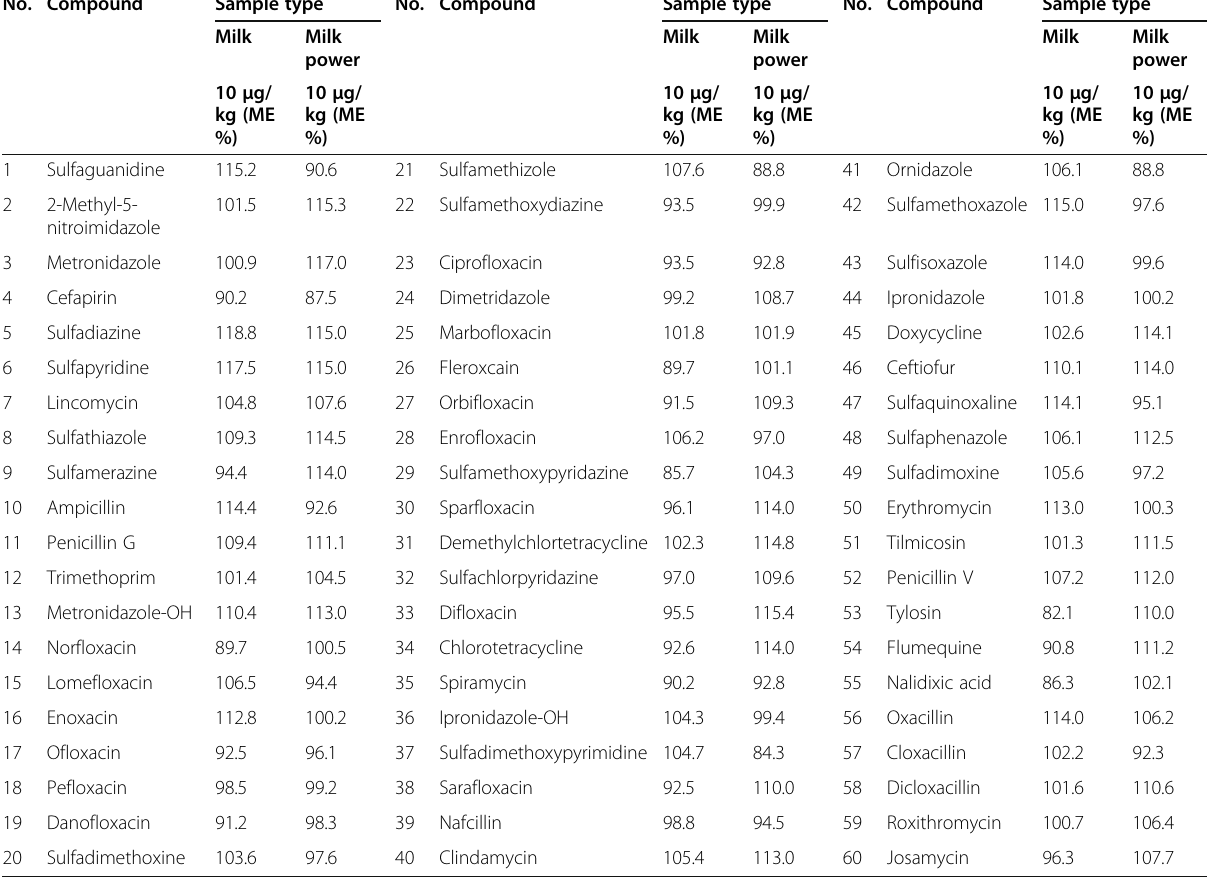
Table 2 Matrix effect (ME) for 60 veterinary antibiotic residues spiked in blank milk and milk power sample for individual donors ( n = 5) No.